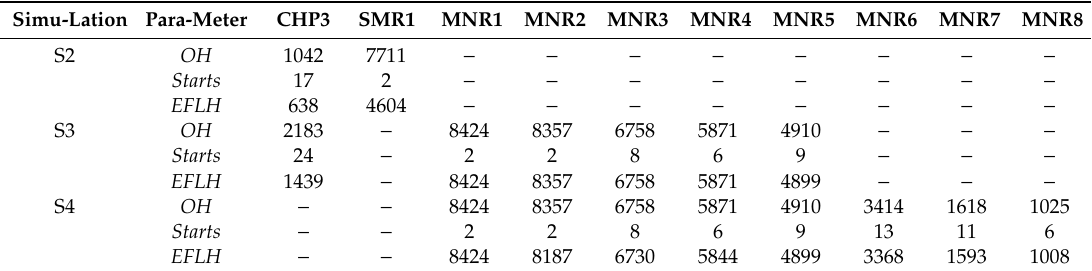
Table 7. Annual operating hours and turn-ons for Simulations